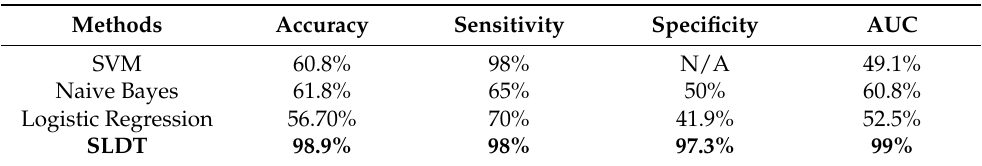
Table 6. Performance measures of the proposed method with other machine learning methods by the MC dataset.